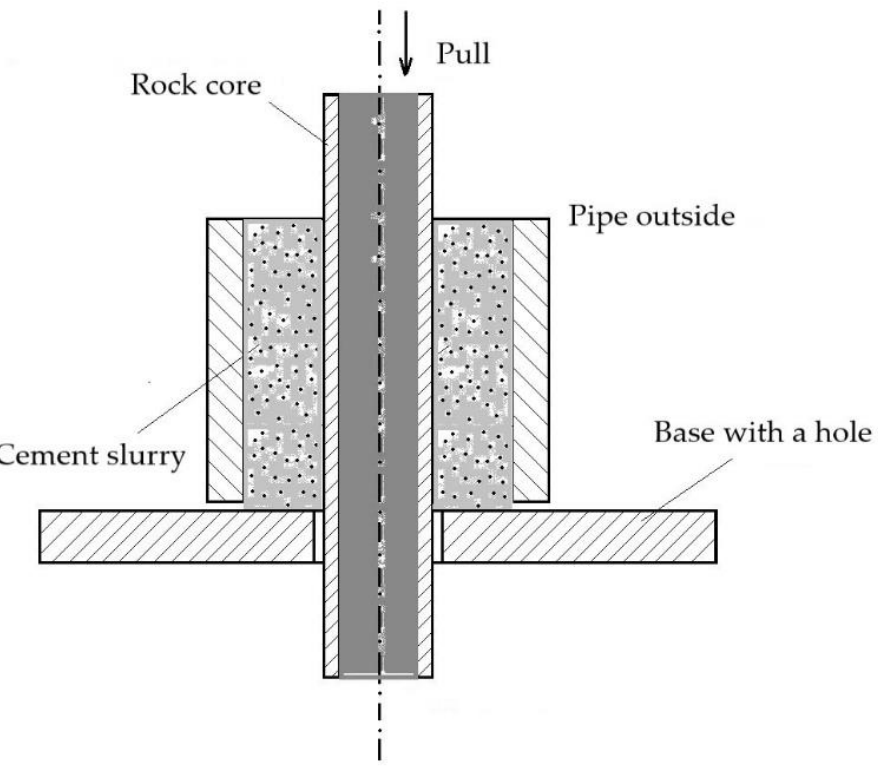
Figure 1. Scheme for determining the adhesion of a cement sheath to steel or rock formation. The factors that affect the adhesion of the hardened cement slurry to the contact surface are mainly [9,12–14]: √ Tight adhesion of the cement sheath to the contact surface; √ Positive volume increase of the setting cement slurry; √ Gelling of the cement slurry on contact with the hydrated subsurface layer of the rock formation; √ pipes with the pumped liquids and then expanding them due to the temperature increase during the setting of the cement slurry; √ Adhesion forces between cement slurry and pipes; √ Bonding of the cement slurry to the surface of the pipes and the surface of the rock formation due to the penetration of slurry into the cavities resulting from the roughness of the contact surface.